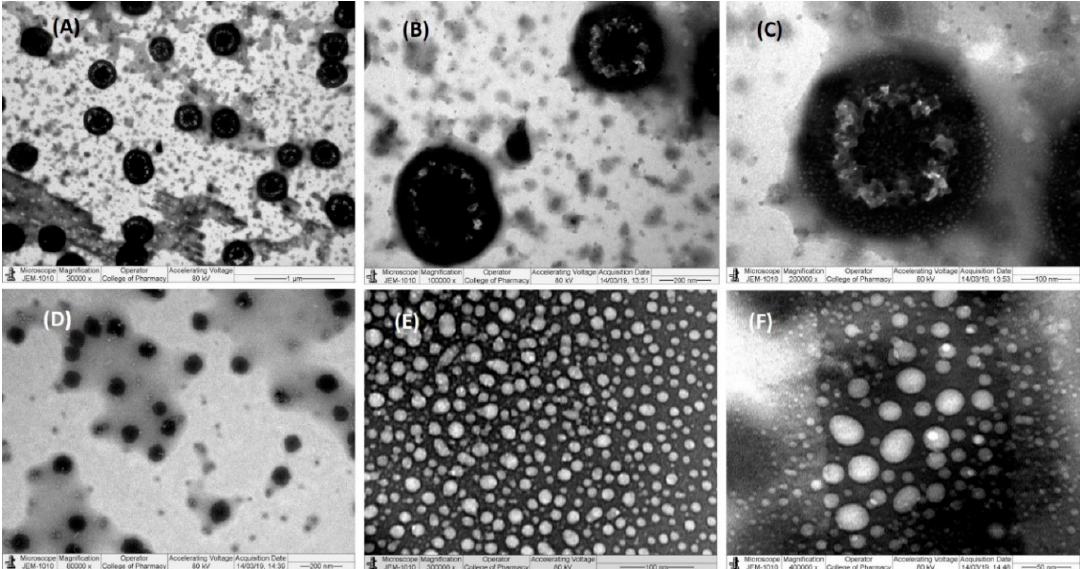
Figure 6. TEM micrographs of CUR - loaded Bio-SNEDDS/SNEDDS. ( A – F ) Images at different magnifications of F4 Bio-SNEDDS and F7 SNEDDS, respectively.